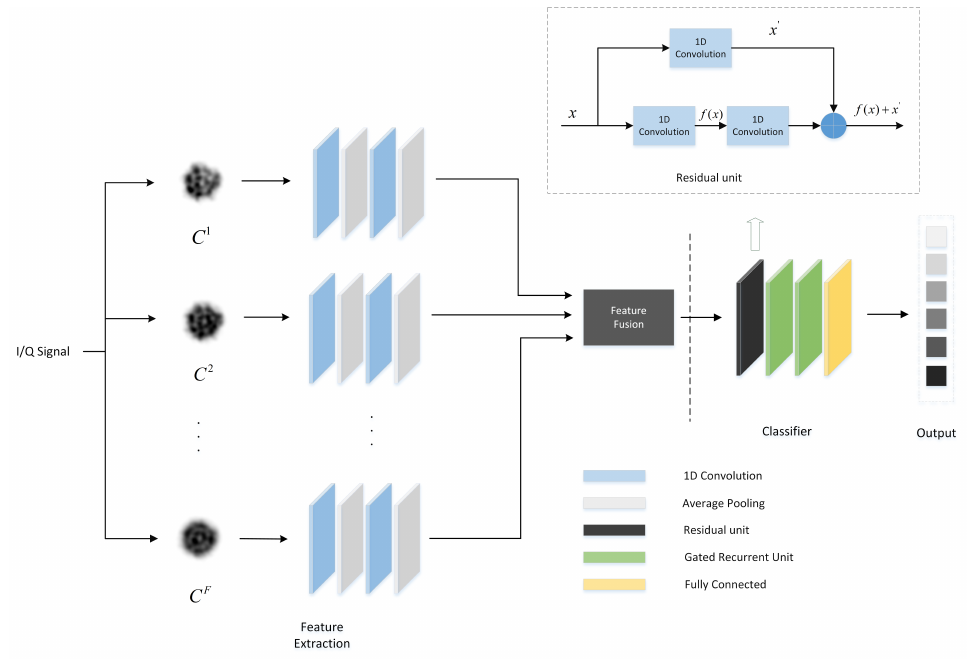
Figure 1. An overview of the proposed